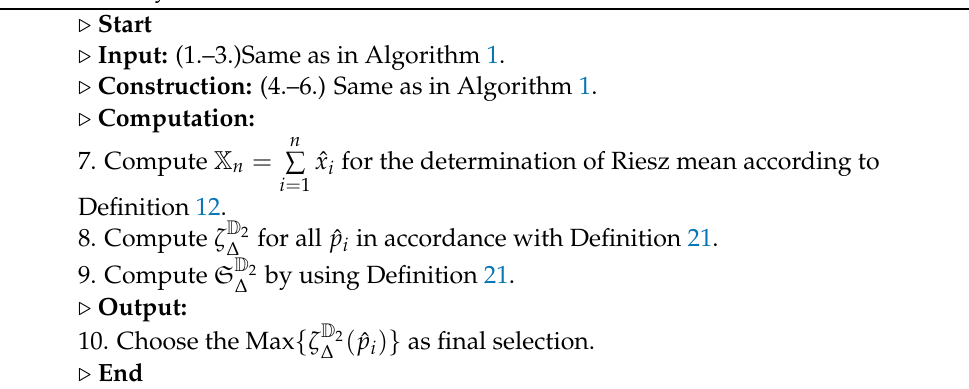
Algorithm 2: Analysis of Heart-related Diseases through the concept of Riesz Summability.